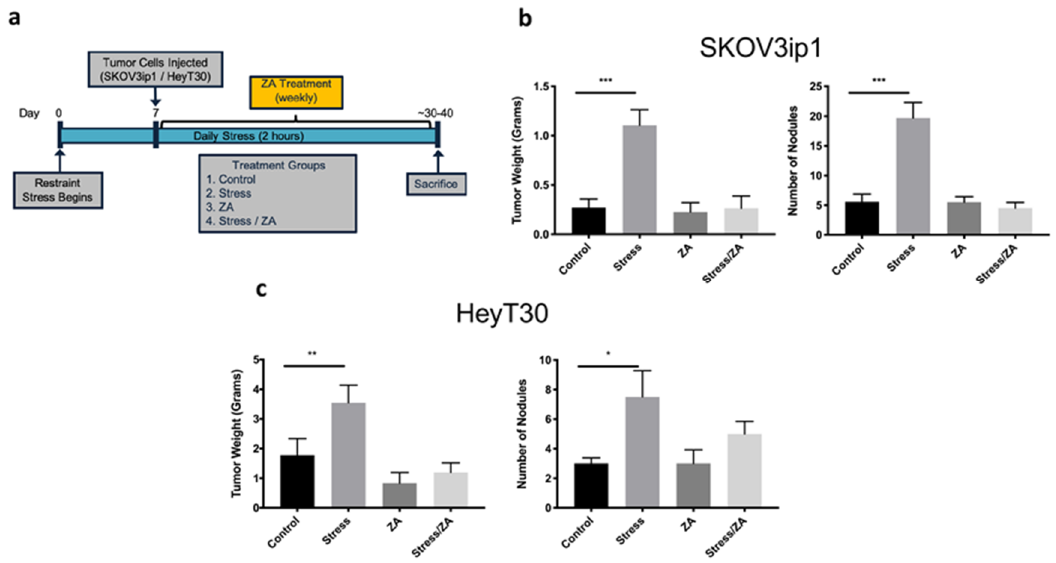
Figure 5. Zoledronic acid (ZA) abrogates restraint stress-induced ovarian cancer tumor growth in an orthotopic Nu/Nu mice model. ( a ) In vivo ovarian cancer orthotopic model timeline ( b ) Tumor weight and tumor nodules in an orthotopic SKOV3ip1 and ( c ) HeyT30 mice model. Stress groups were subjected to daily restraint stress (2 hrs/day), while ZA treatment was administered weekly. Mean ± SEM. * p < 0.05 ** p < 0.01 *** p < 0.0001.